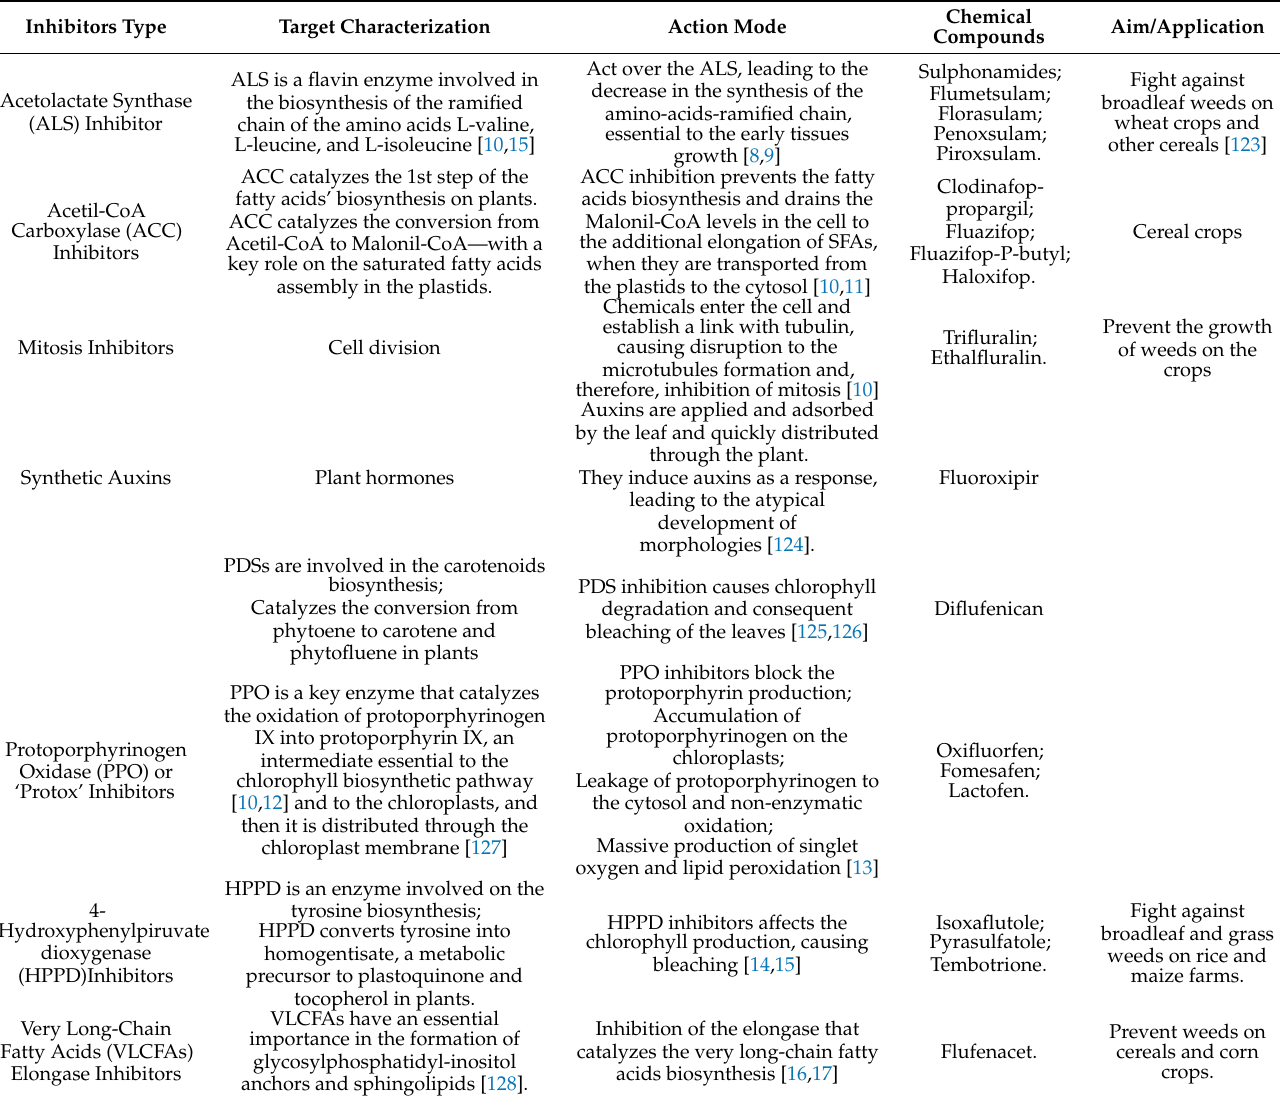
Table 1. Fluorinated-based herbicides and its action